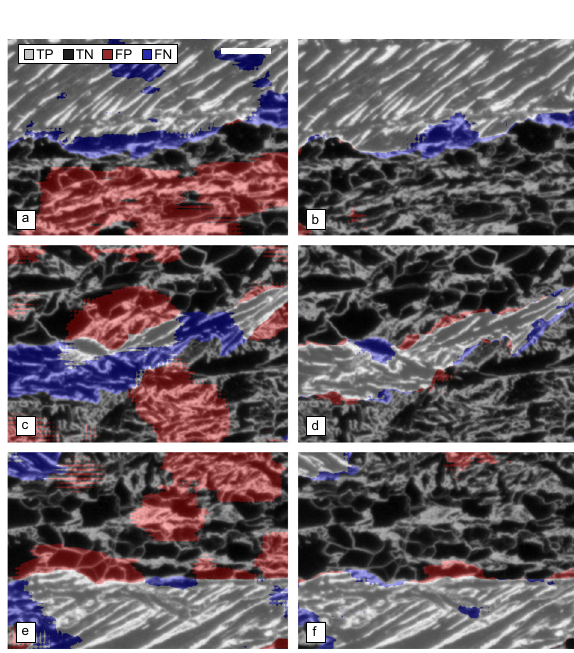
Fig. 4 Predictions on the intensity-inverted target 3 test images. The left column ( a ), ( c ), ( e ) give the predictions of a DeepLabv2 model trained on the source dataset (cf. experiment T3.1). The right column ( b ), ( d ), ( f ) give the predictions of a DeepLabv2 model trained with the UDA framework on the source and target 3 datasets (cf. experiment T3.2). TP, TN, FP, and FN stand for true positives, true negatives, false positives, and false negatives, respectively, the positive class being the lath-bainite foreground. The scale bar width corresponds to 10 μ m.